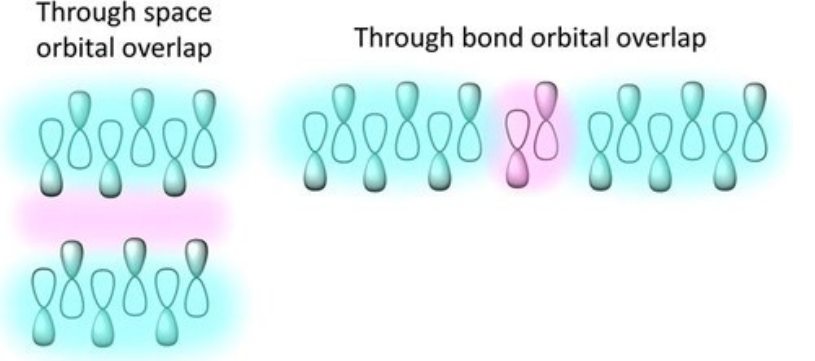
Figure 5. Orbital overlap of chromophores through space and through bonds. Reproduced with the permission from [73], copyright 2020 AIP Publishing.